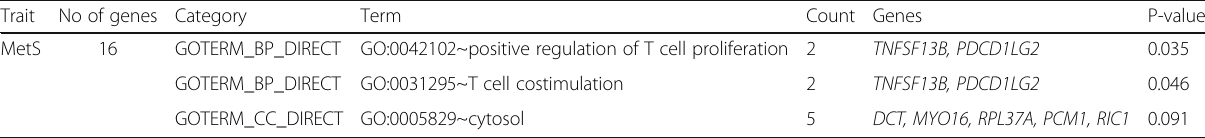
Table 5 Functional annotation results of 16 genes for MetS using DAVID Bioinformatics Resources 6.8 Trait No of genes